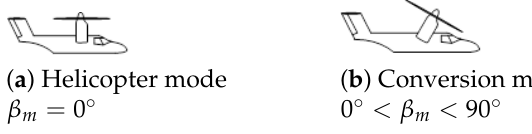
Figure 1. Three flight modes of the tiltrotor